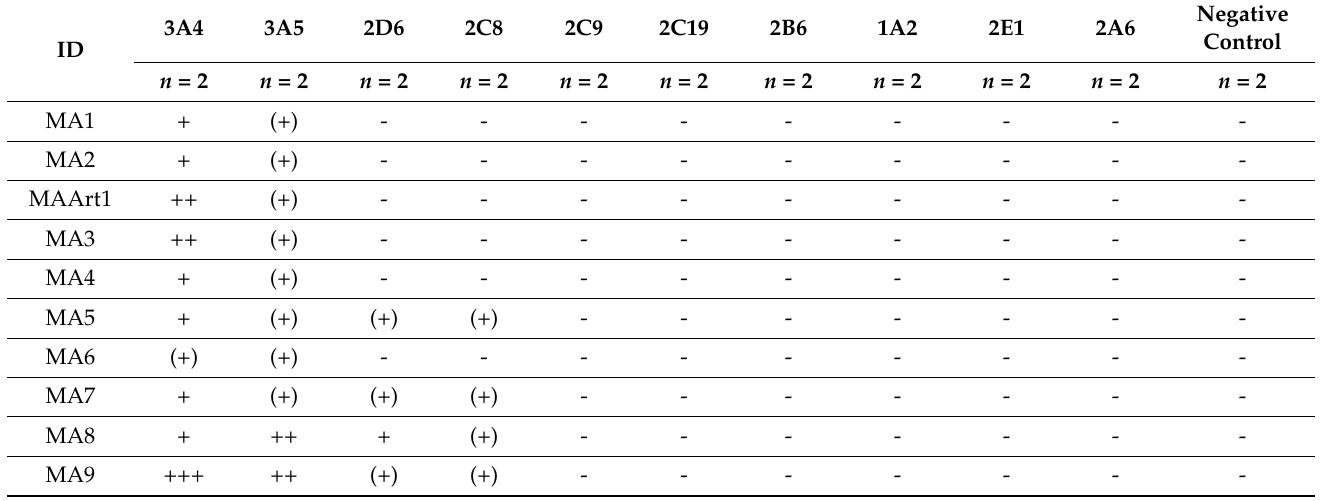
Table 4. Summary of the incubation results of ADAMANTYL-THPINACA with rCYP. Area ratios (absolute peak are (metabolite)/absolute peak area (ISTD)) are expressed as follows: (+): <0.1, +: ≥ 0.1– ≤ 1, ++: >1– ≤ 5, +++: >5. Where the negative control contained trace amounts of metabolites in a comparable amount, as in the samples after incubation, the result is marked as: (+)